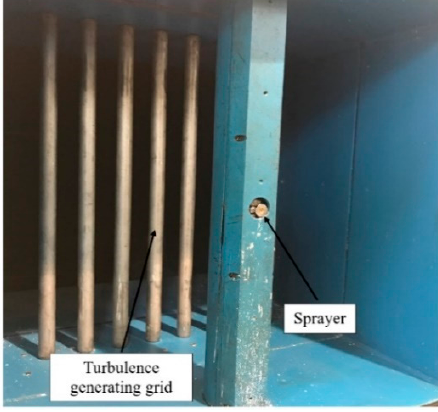
Figure 4. Picture of the wax sprayer and turbulence generating. Table 2. Wax spray system working conditions.